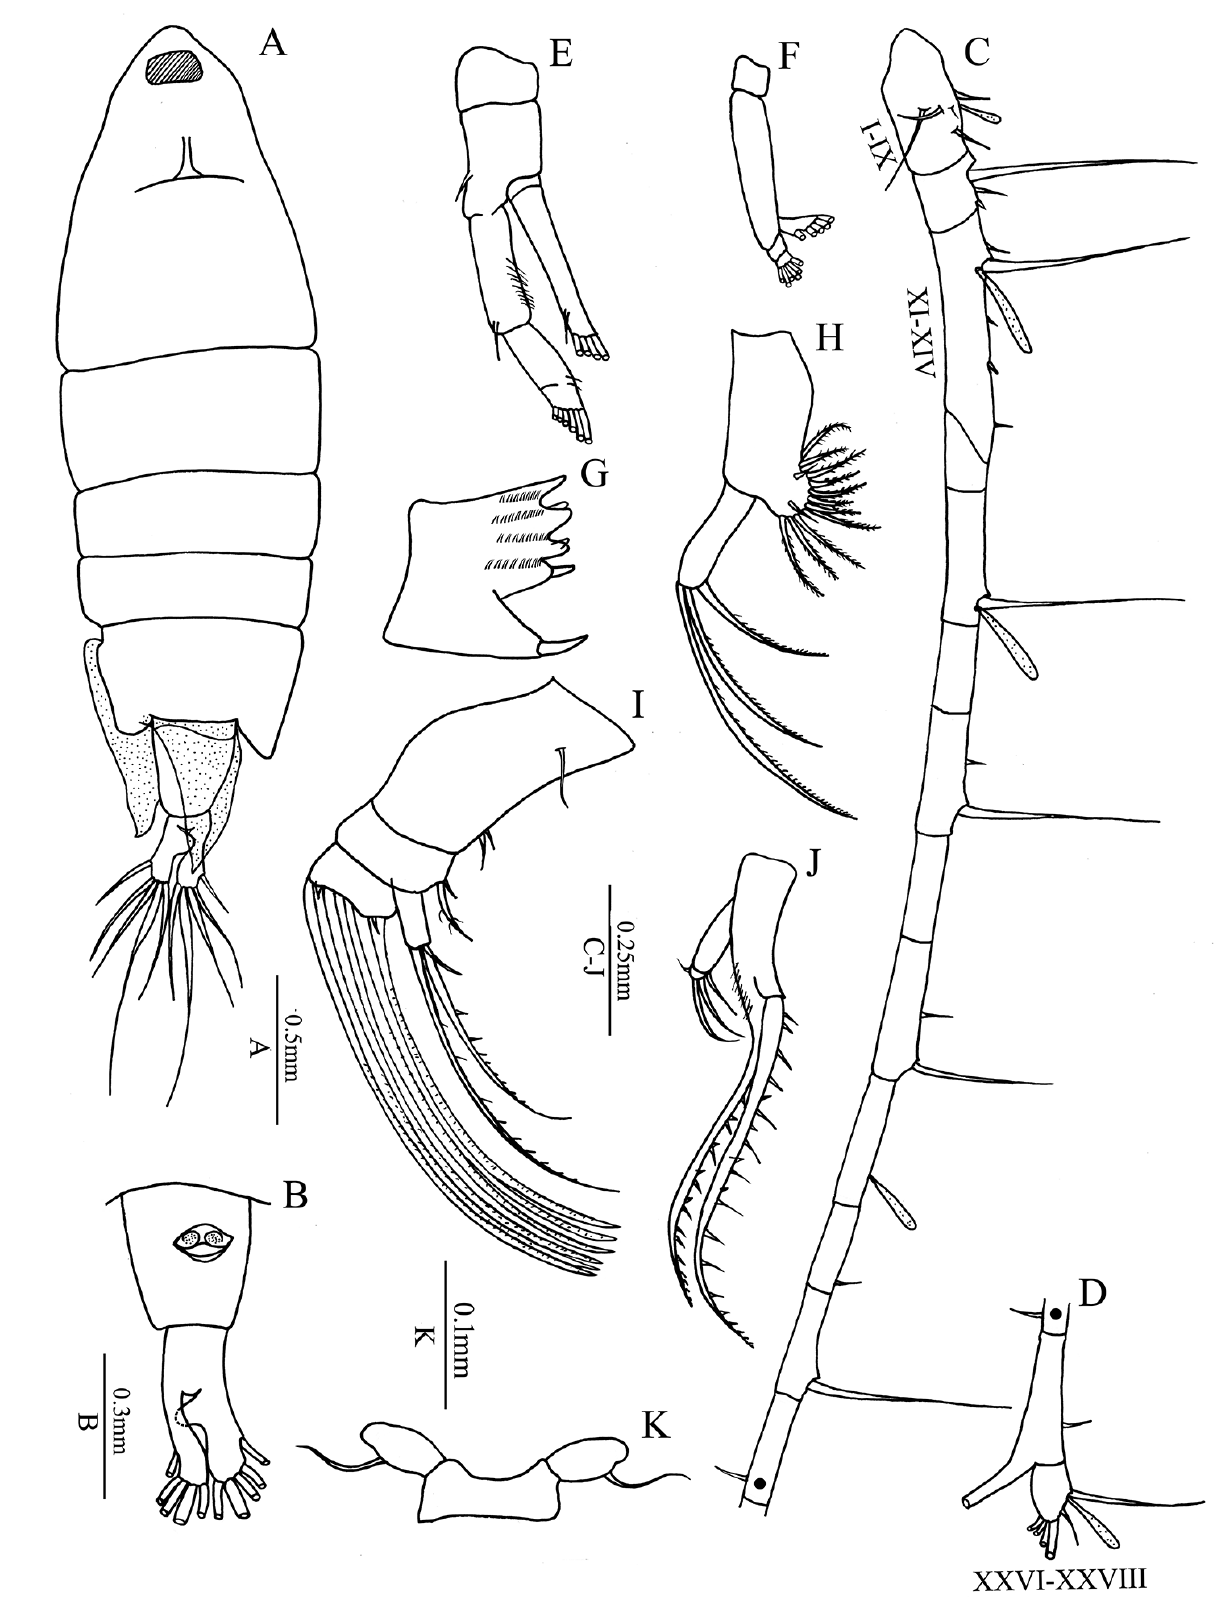
Figure 2. Tortanus ( Atortus ) dhritiae sp. nov., female (holotype): A ) habitus dorsal view; coupling device is dotted; B ) urosome ventral view; C , D ) antennule; E ) antenna; F ) mandible palp; G ) mandible gnathobase; H ) maxillule; I ) maxilla; J ) maxilliped; K ) leg